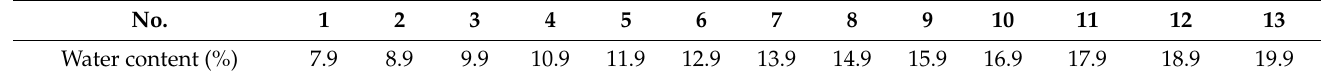
Table 4. Groups of soil samples for the test of valid range of water content of